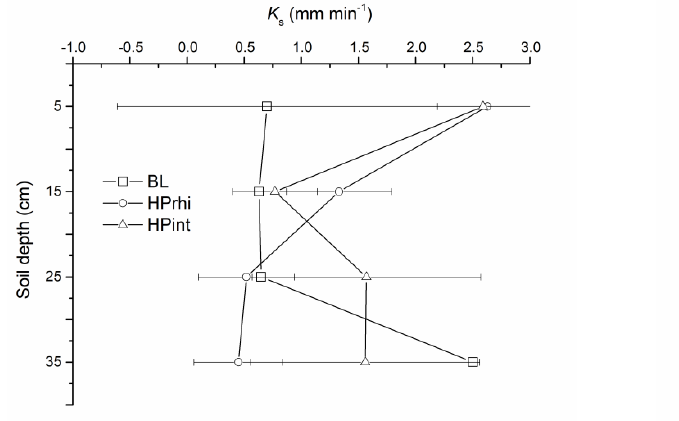
Table 5. Correlations of basic soil properties with soil pore characteristics at 0–40 cm soil for all studied plots .